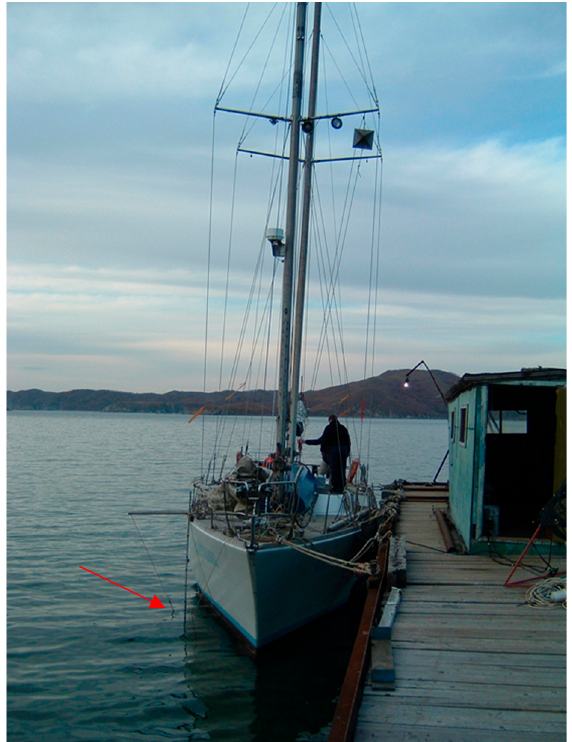
Figure 1. A boat with an ADCP installed (its position is shown with a red arrow) for research in the offshore